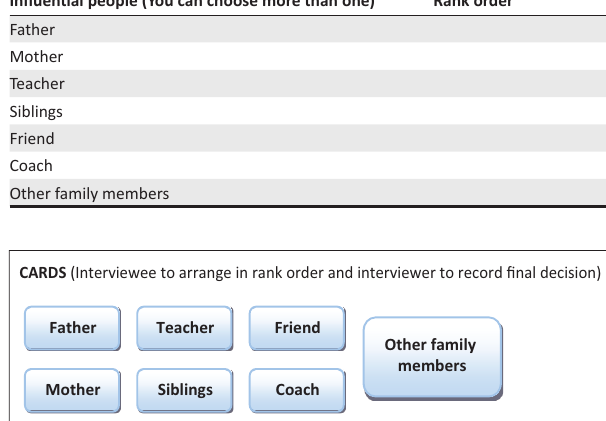
TABLE3: Example of (multiple-choice and ranking-scale) question used in a survey via interview. Influential people (You can choose more than one)